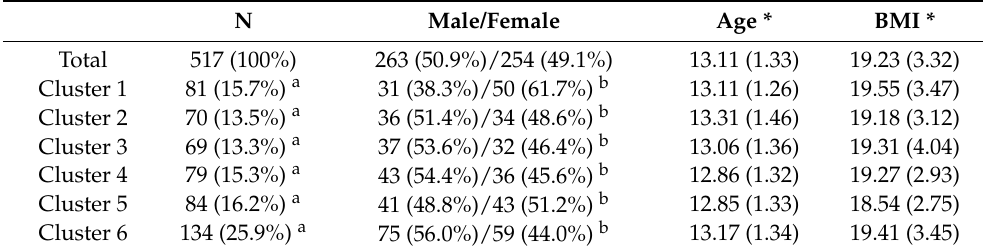
Table 2. Description of the clusters by sex/gender, age, and weight